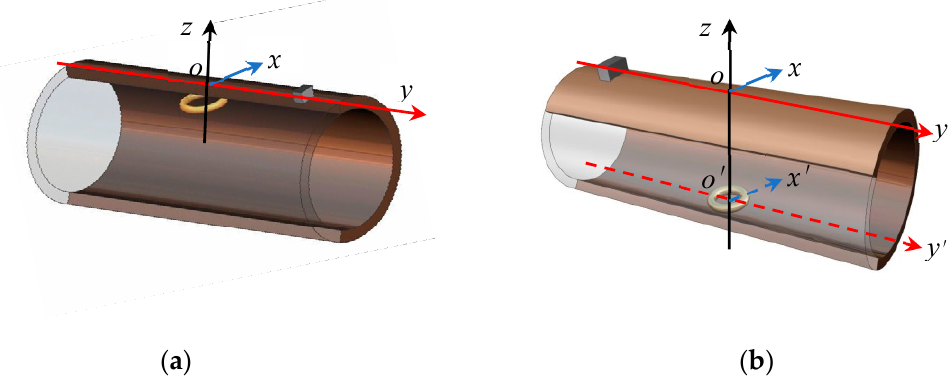
Figure 5. Position of the current-carrying coil. ( a ) On the top of the inner wall of the pipe. ( b ) At the bottom of the inner wall of the pipe.